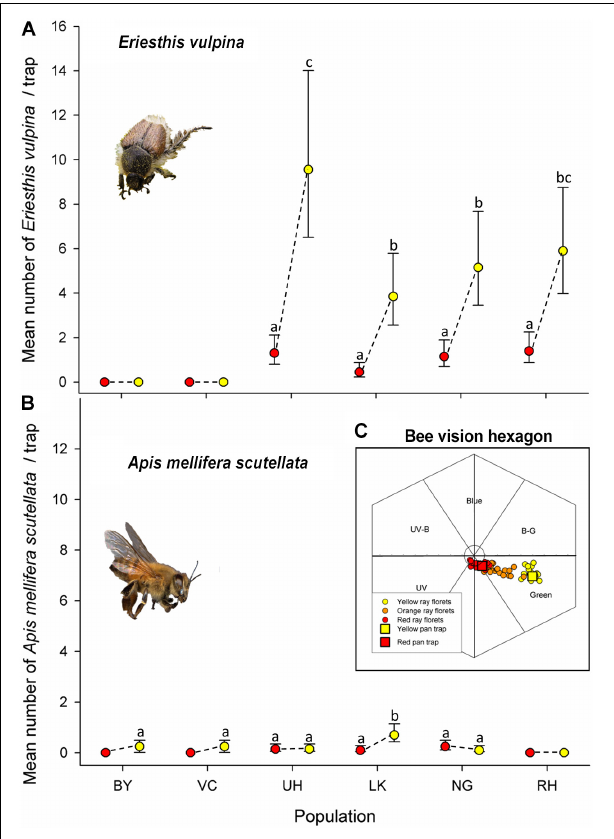
FIGURE 6 | Mean numbers of hopliine scarab beetles and honeybees caught in yellow and red pan traps at the six study sites during an 8-h period. (A) Eriesthis vulpina (no individuals were trapped at the BY and VC sites) and (B) Apis mellifera scutellata , and (C) ray floret colors of the yellow, orange and red forms of Gerbera aurantiaca and red and yellow pan trap spectra as loci in the hymenopteran visual space hexagon. The six segments represent the six categories of bee color perception. Distance of the loci from the origin gives an indication of the ability of bees to perceive the color and distance between loci the ability to discriminate between the colors. Mean Euclidean distances from origin ± SD: yellow 0.52 ± 0.048 N = 16, 0.27 ± 0.11 N = 10 for orange and 0.107 ± 0.036 N = 20 for red. Vertical bars indicate 95% confidence intervals. Means sharing letters are not significantly